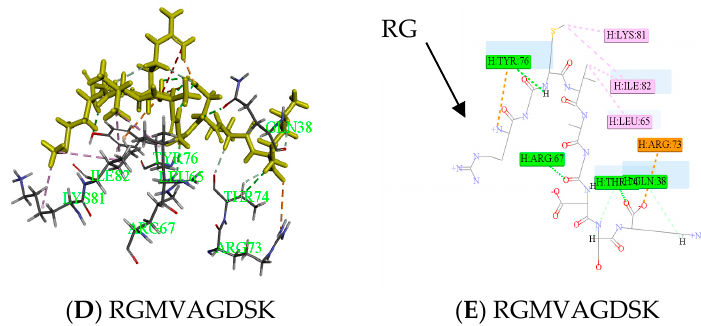
Figure 6. Active mechanism of peptide and amino acids of thrombin interact with peptides (ELEDSLDSER and RGMVAGDSK) were shown. Yellow sticks were peptides and others were amino acids identified by the green label in ( A , D ). All interactions between peptides and thrombin were shown in ( B , E ). Different colors represented different roles. The hydrophobic interaction was done in ( C ). The closer the color gets to darker blue, the stronger the hydrophilic.